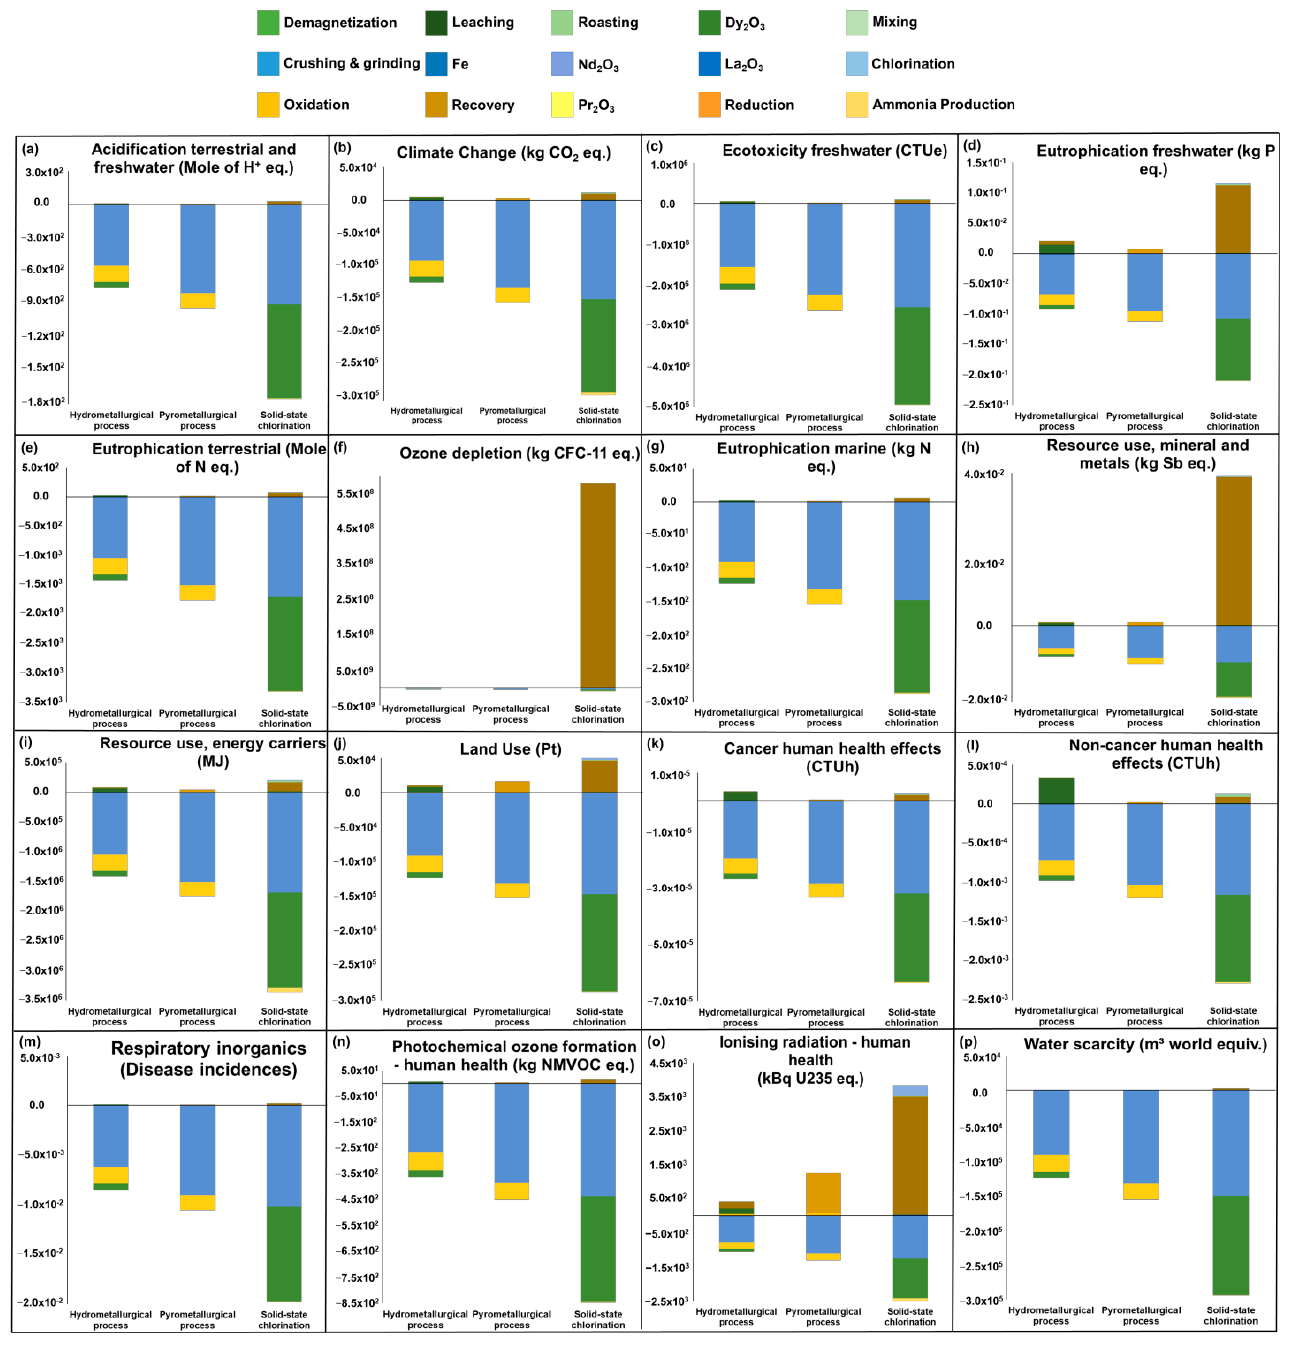
Figure 4. Results of classification and characterisation steps of LCA, the figures from a – p represent the considered impact categories (functional unit: 1000 kg of Nd-Fe-B permanent magnets).